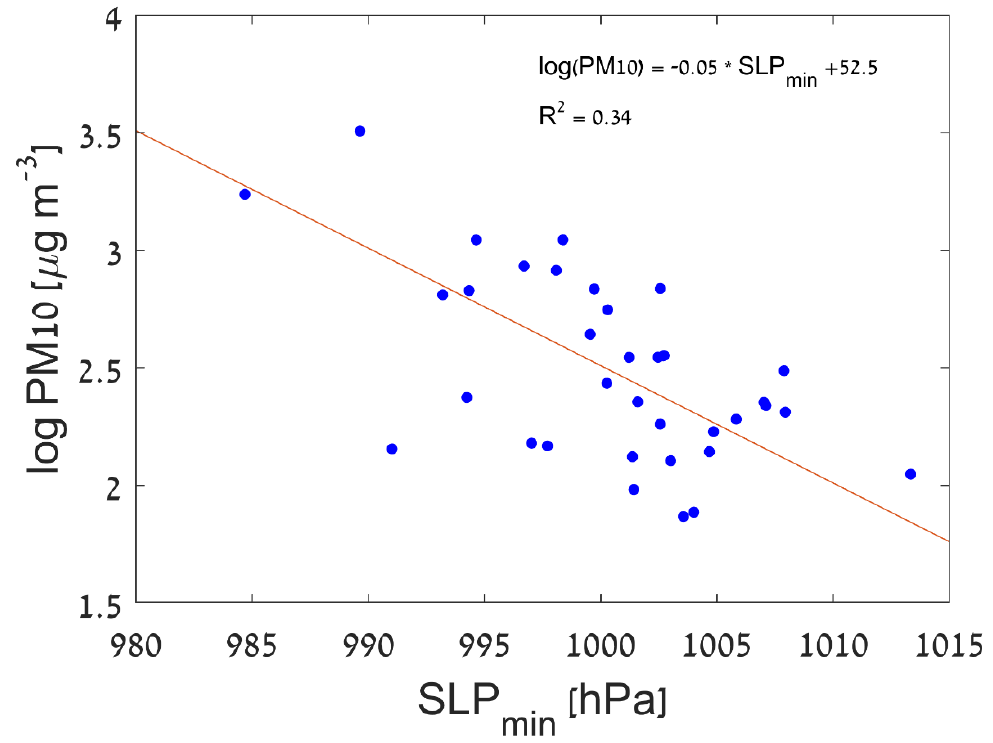
Figure 4. Minimum sea-level pressure (SLP) within 20–40° E, 20–40° N and PM 10 concentrations ( µ g / m 3 ) in Be’er Sheva during days that fall within the back trajectory cluster associated with the highest PM 10 values.